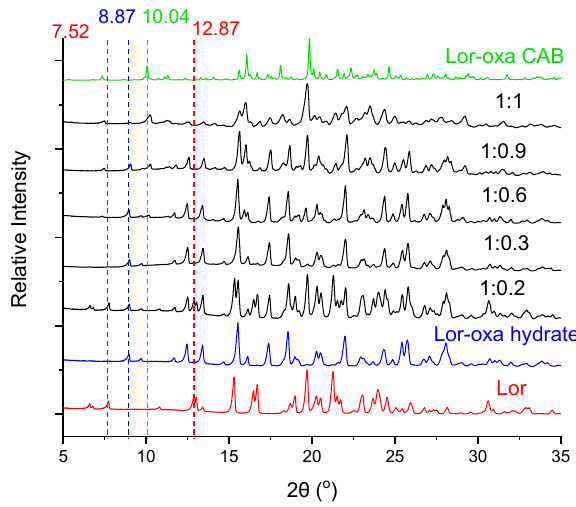
Figure 4. E ff ects of Oxa amount on phase change during slurry experiments. Lor to Oxa ratios are given.